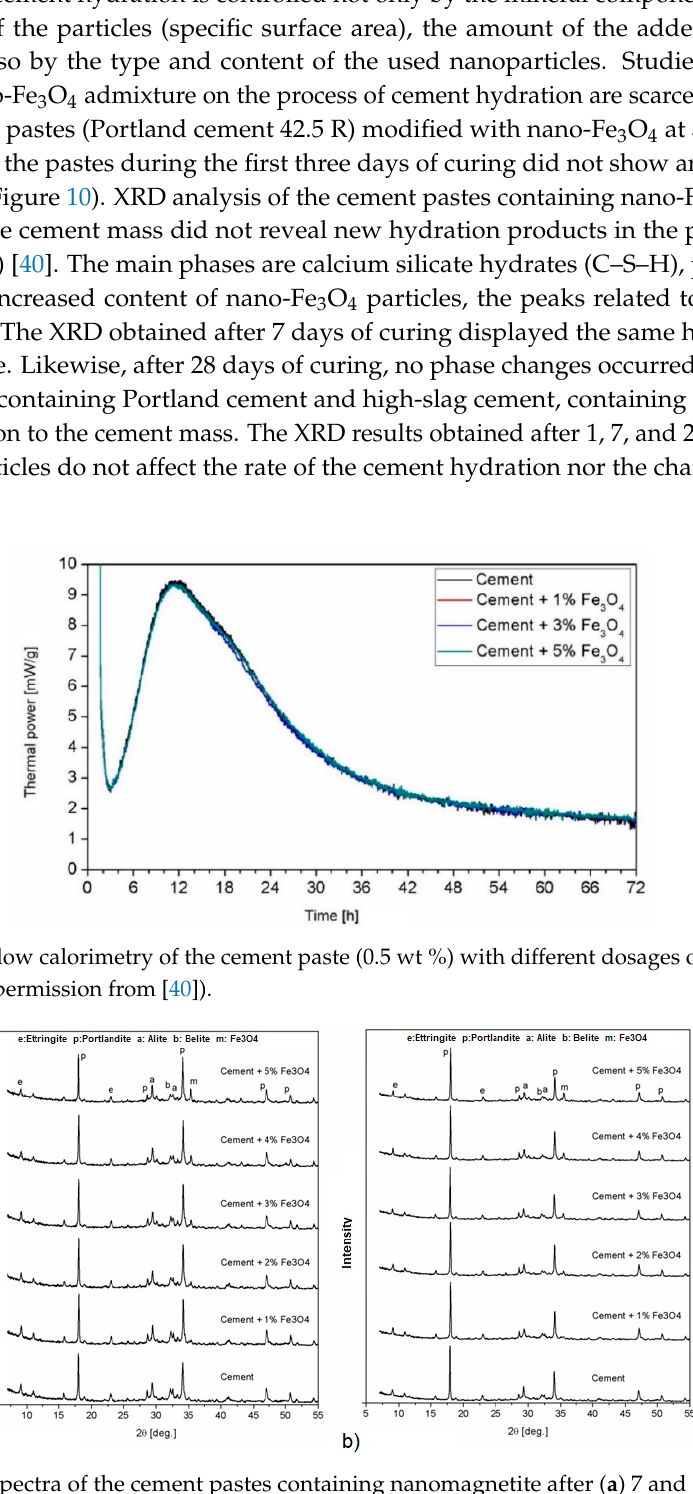
Figure 11. XRD spectra of the cement pastes containing nanomagnetite after ( a ) 7 and ( b ) 28 days of curing (Reprinted with permission from [41]).